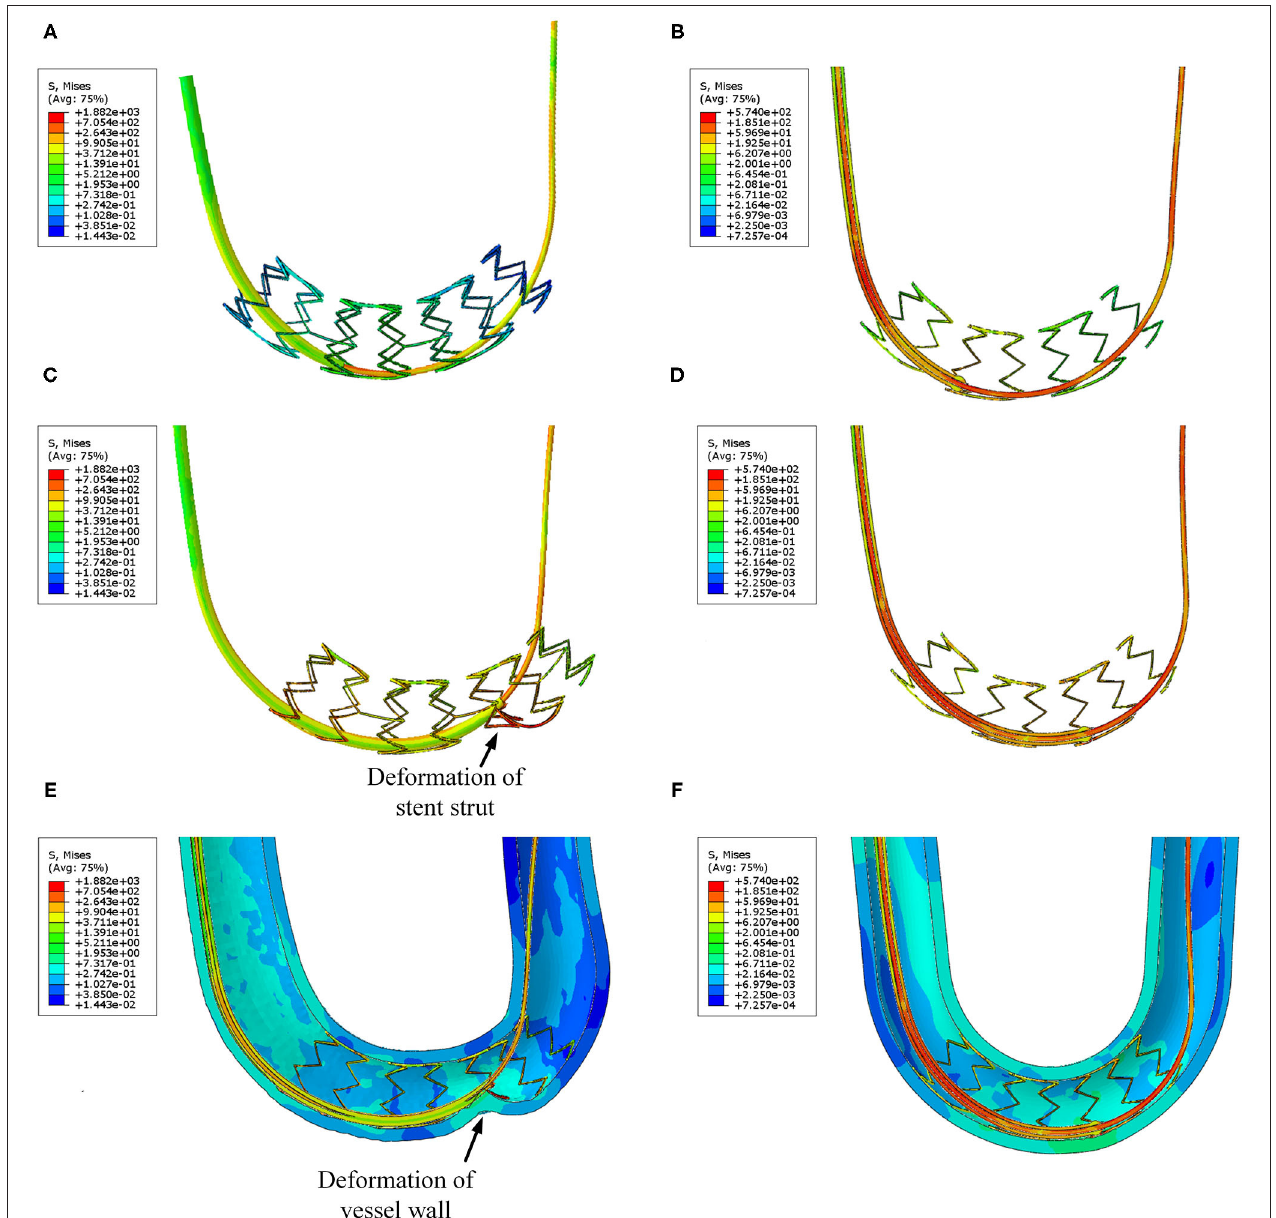
FIGURE 11 | Visualizations of FEA for the post-dilation. (A) Stress distribution of the traditional catheter at 0.8s, (B) stress distribution of spherical-tip catheter at 0.8s, (C) stress distribution of traditional catheter at 1.1s, (D) stress distribution of spherical-tip catheter at 1.1s, (E) section view of the traditional catheter model, and (F) section view of the spherical-tip catheter